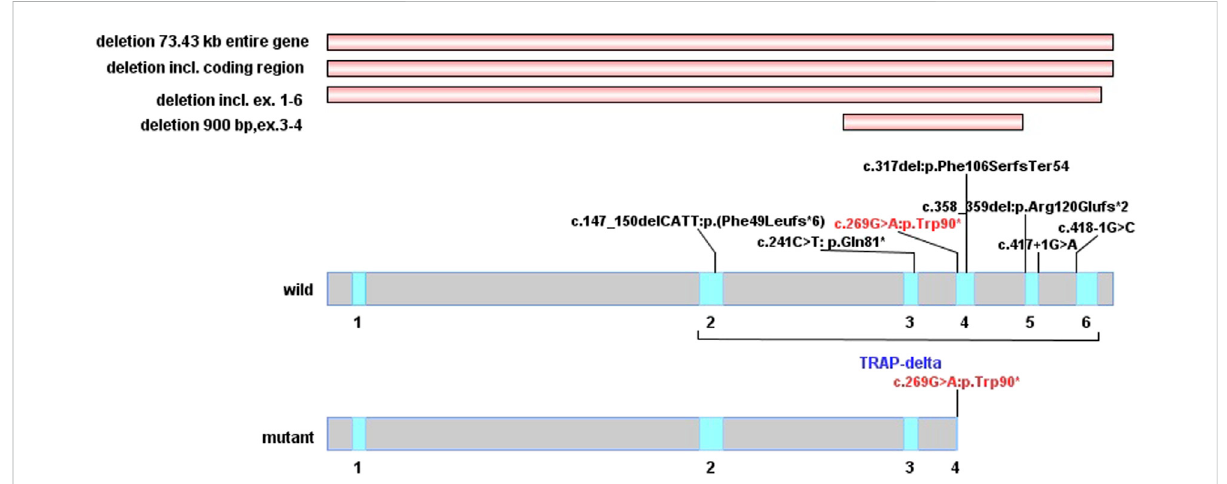
FIGURE 3 Distribution of SSR4 gene mutation. (The red horizontal stripes are the previously reported type of copy number variations. In wild-type and mutant protein domains, the red font is the variation reported in this study, and the black variations are previously reported. The blue area of delta subunit precursor (TRAP-delta) contains fi ve exons from exon2 to